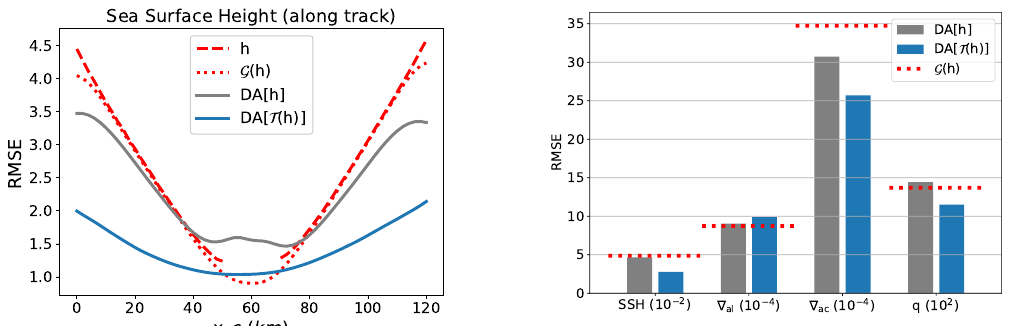
Figure 7. Left: Along track RMSE over the 54 passes on SSH (10 − 2 m) of h , G ( h ) , DA[ h ], and DA[ T ( h ) ] against h t (see Table 2 for notations). Right: Global RMSE on SSH (10 − 2 m), along and across track gradients ∇ al and ∇ ac respectively (scaled by 10 − 4 ) and relative vorticity q (scaled by 10 2 ).